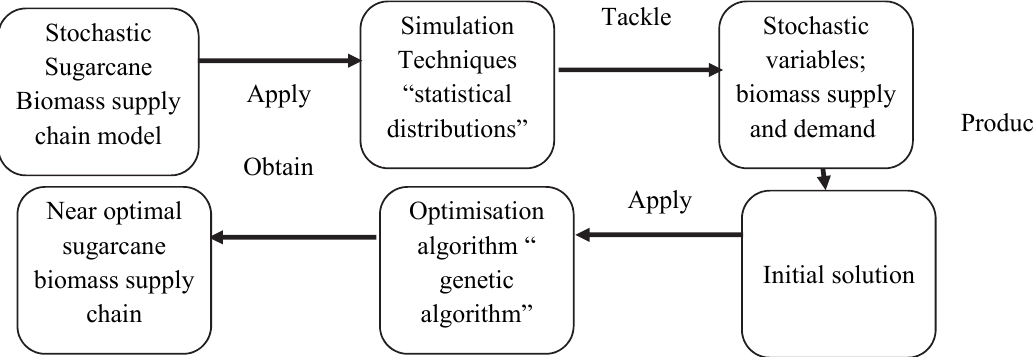
Fig. 3. Hybrid Simulated Annealing/Genetic Algorithm for biomass supply